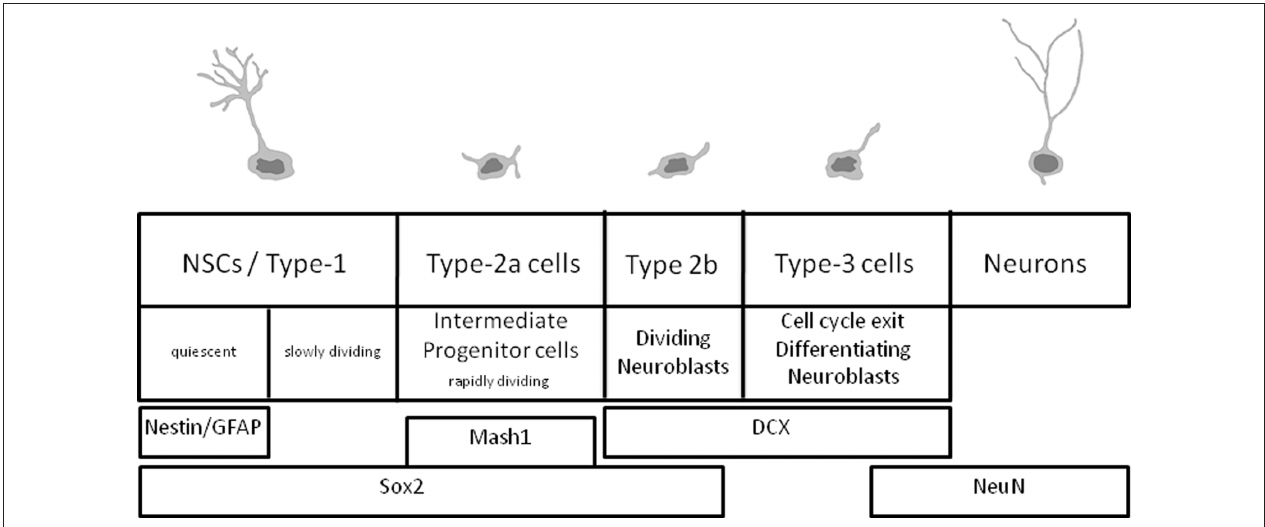
FIgUre 1 | Summary of the cell types in adult hippocampal neurogenesis and the expression of the main